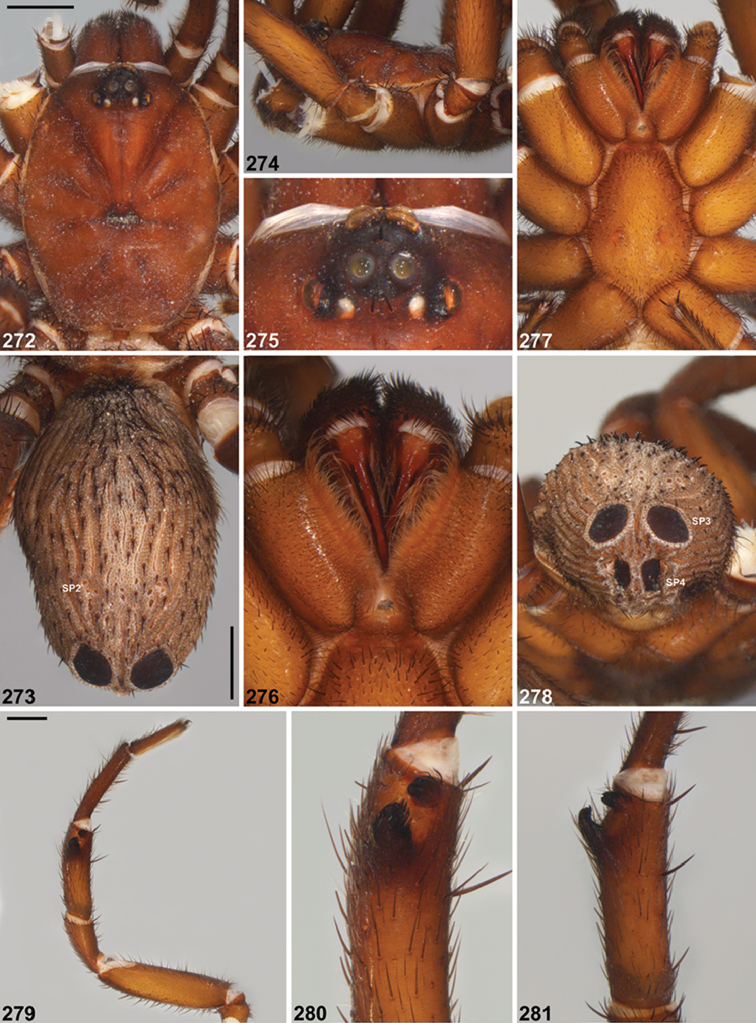

Idiosoma
kwongan sp. n., male holotype (WAM T27142) from E. of Greenhead (Western Australia; GES), somatic morphology. 272–273 Carapace and abdomen, dorsal view 274 Carapace, lateral view 275 Eyes, dorsal view 276 Mouthparts, ventral view 277 Sternum, ventral view 278 Abdomen, posterior view 279 Leg I, prolateral view 280 Leg I tibia, clasping spurs, prolateral view 281 Leg I tibia, proventral view. Scale bars 2.0. SP2–4 = sigilla pairs 2–4.